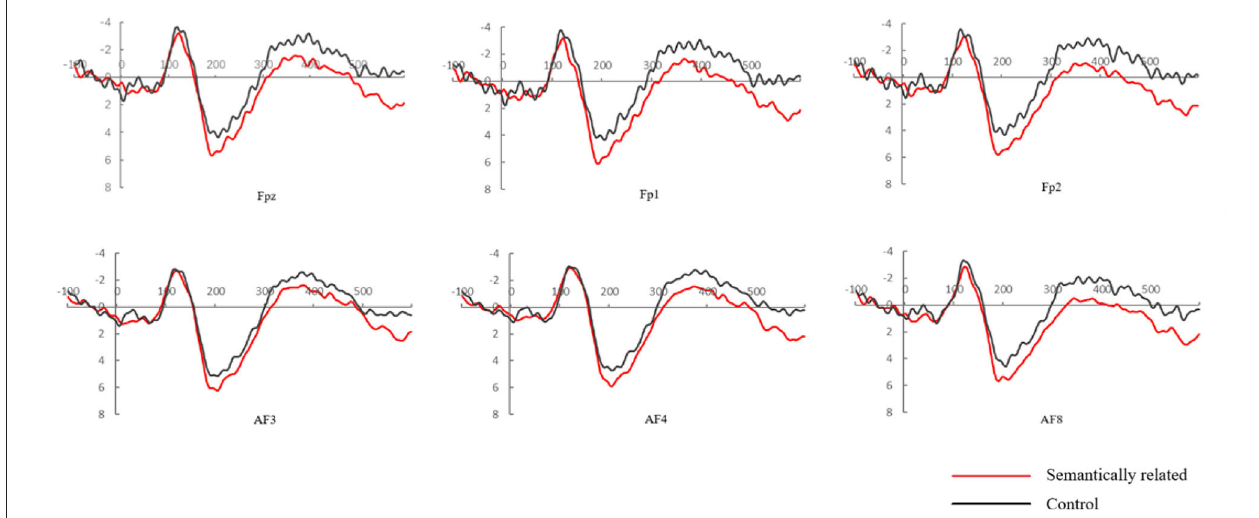
FIGURE 6 | Grand mean event-related potentials in response to target words, from 6 anterior frontal electrodes (Fpz, Fp1, Fp2, AF3, AF4, and AF8), for the semantically related and control pairs of low-frequency in the homophone task.